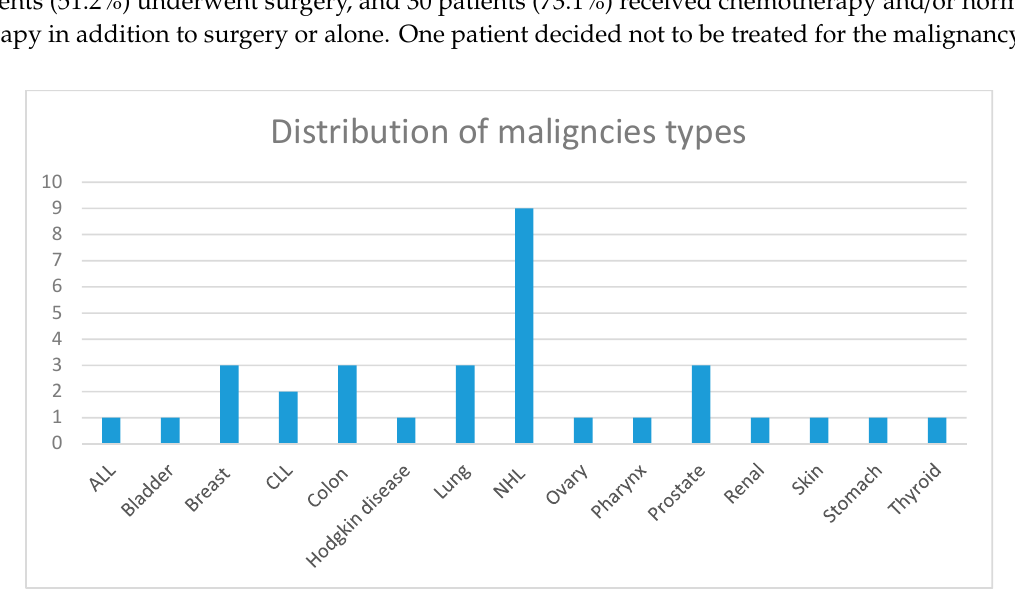
Figure 2. Distribution of the types of malignancy.